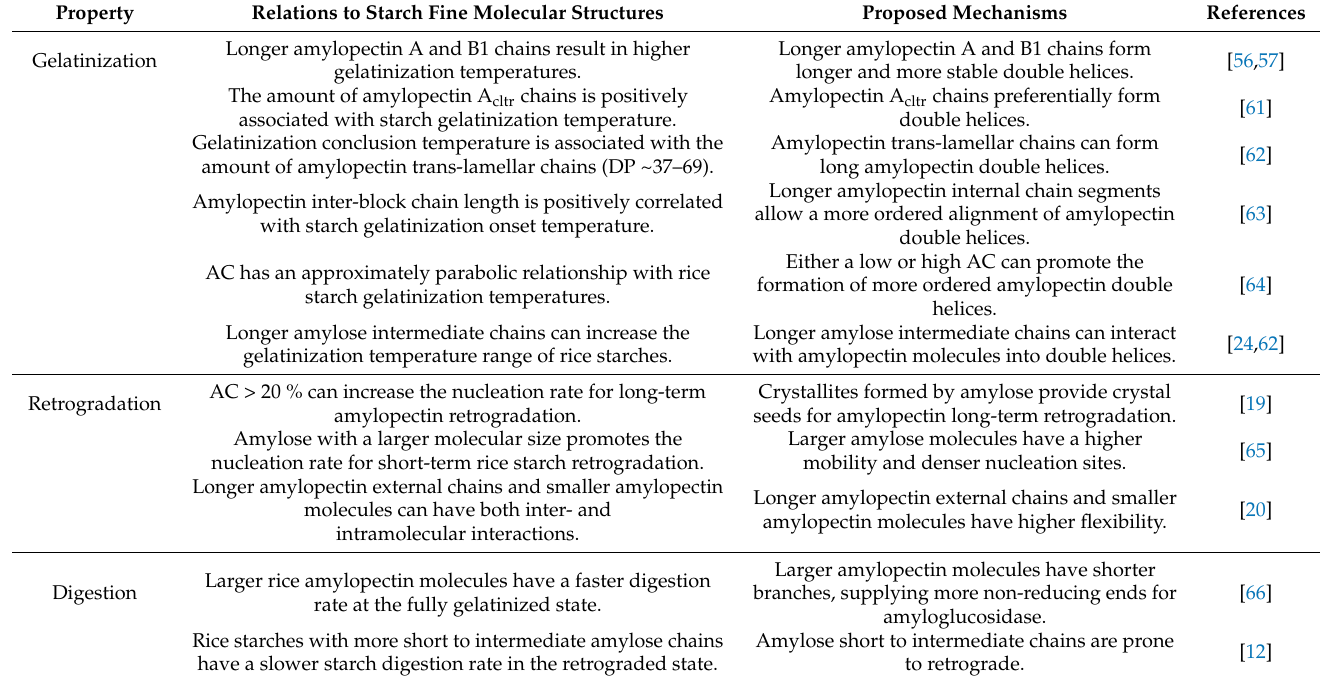
Table 2. Relations between rice starch fine molecular structures with its gelatinization, retrogradation and digestion properties, with possible mechanisms